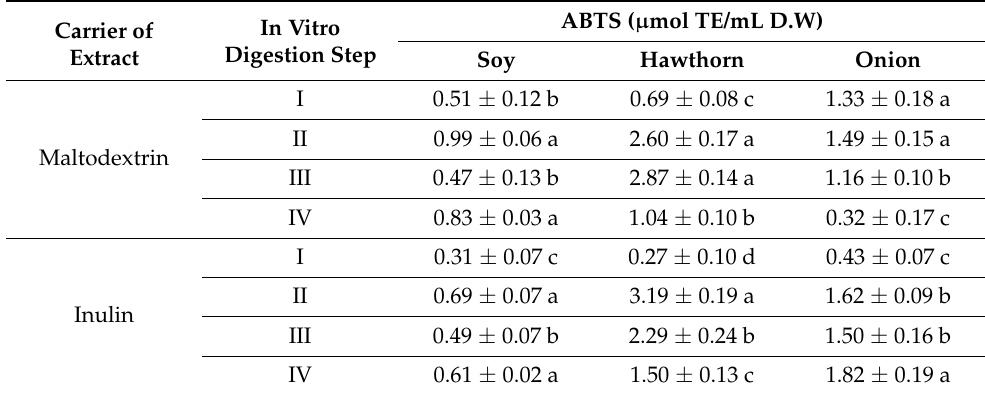
Table 4. ABTS antioxidant capacity ( µ mol TE/mL D.W.) of liquids released during in vitro digestion of wheat bread enriched with different extracts.